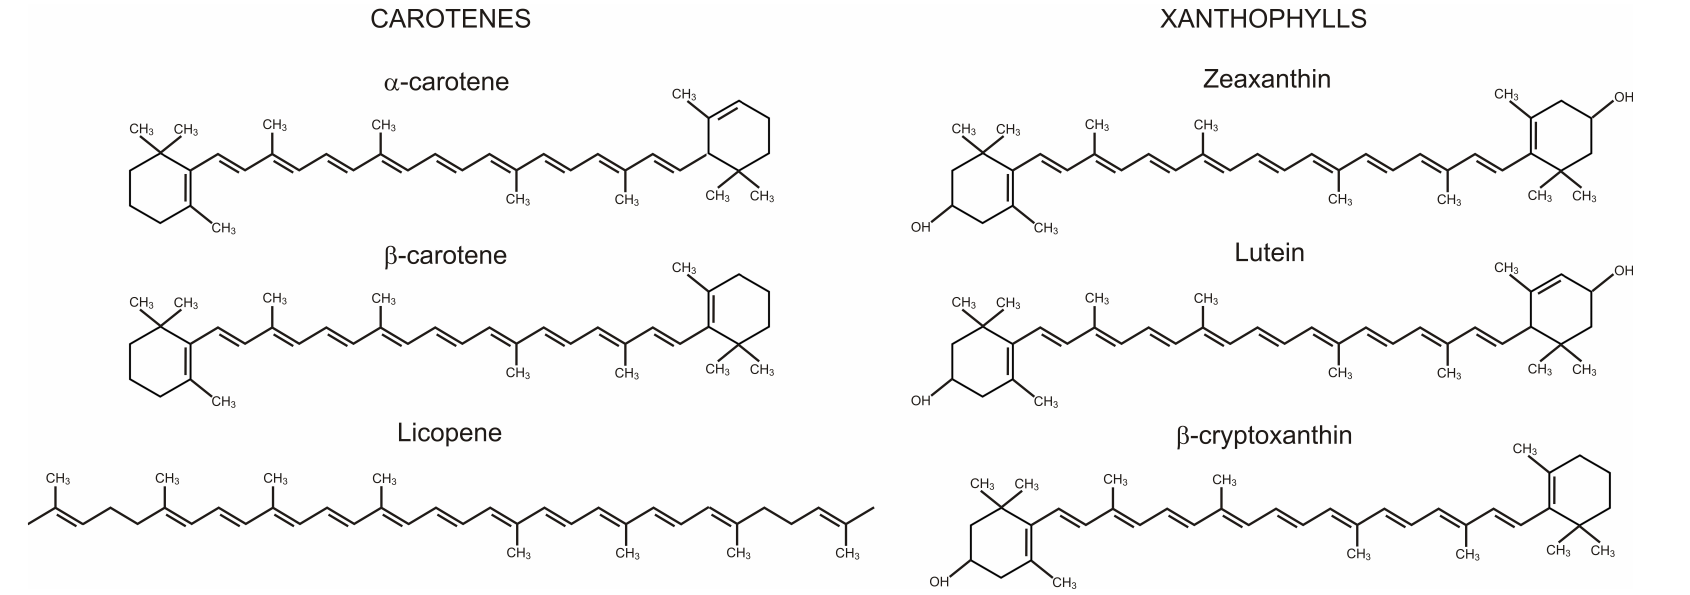
Figure 3. Structures of carotenes and xanthophylls that are important for human